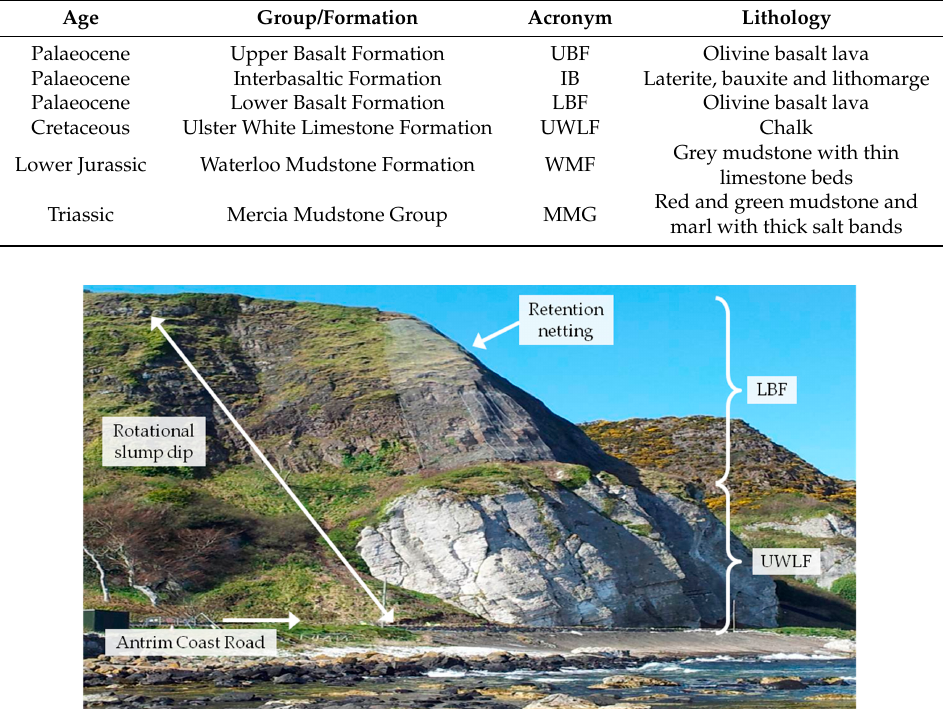
Figure 14. Slope instability at Garron Point. Photograph taken in 2012. Preventative measures that were put in place to minimise risk from rock-falls are indicated. UWLF: Ulster White Limestone Formation; LBF: Lower Basalt Formation.